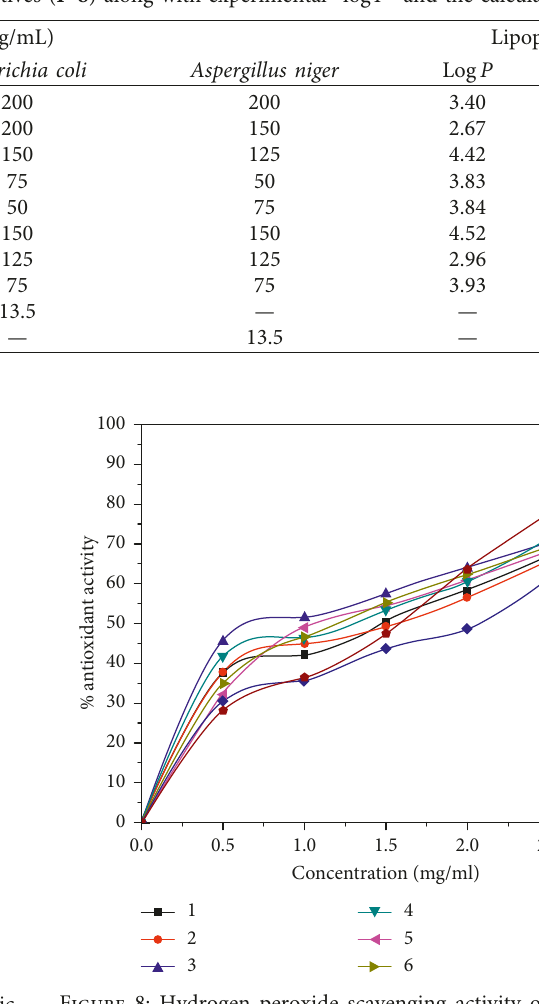
Figure 7: DPPH free radical scavenging activity of the heterocyclic Schiff base derivatives ( 1 – 8 ).